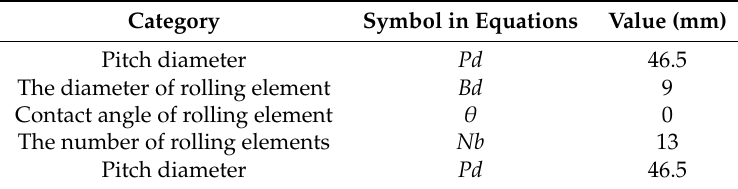
Table 2. The specification of the target bearing, FAG